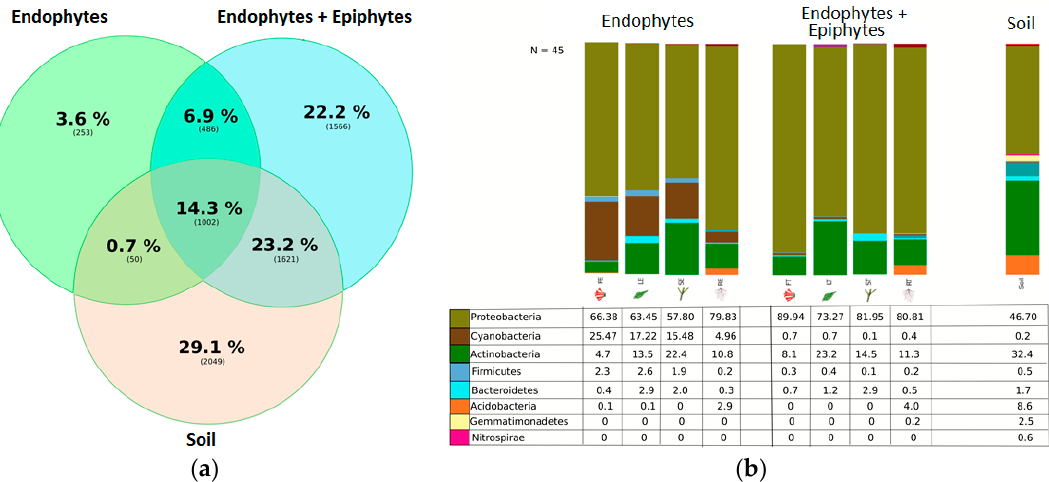
Figure 1. ( a ) Ven diagram showing the operational taxonomic unit (OTU) distribution among groups. OTU phylotypes are shown in brackets and their percentage representation among endophyte, endophyte+epiphyte and soil bacterial samples. ( b ) Relative abundance of bacteria at phylum level. Percentage of each phylum is shown in the different plant parts and soil among the endophytes, endophytes+epiphytes and s oil sample